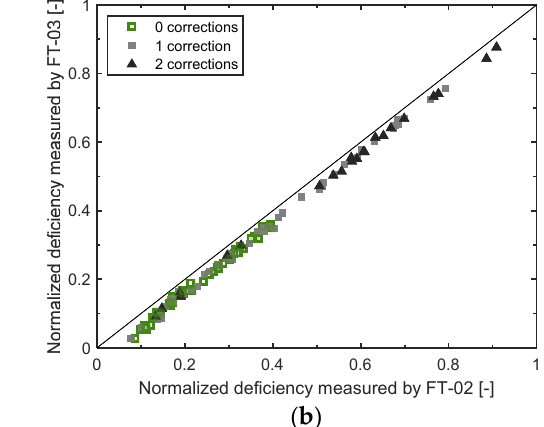
Figure 12. Parity plots reporting the deficiency of reactant D loaded to R201 as measured by sensors FT-02 and FT-03 during ( a ) Step A, and ( b ) Step B. The different shapes of the markers denote a different number of corrections eventually required. The axis scales have been normalized to protect data confidentiality.